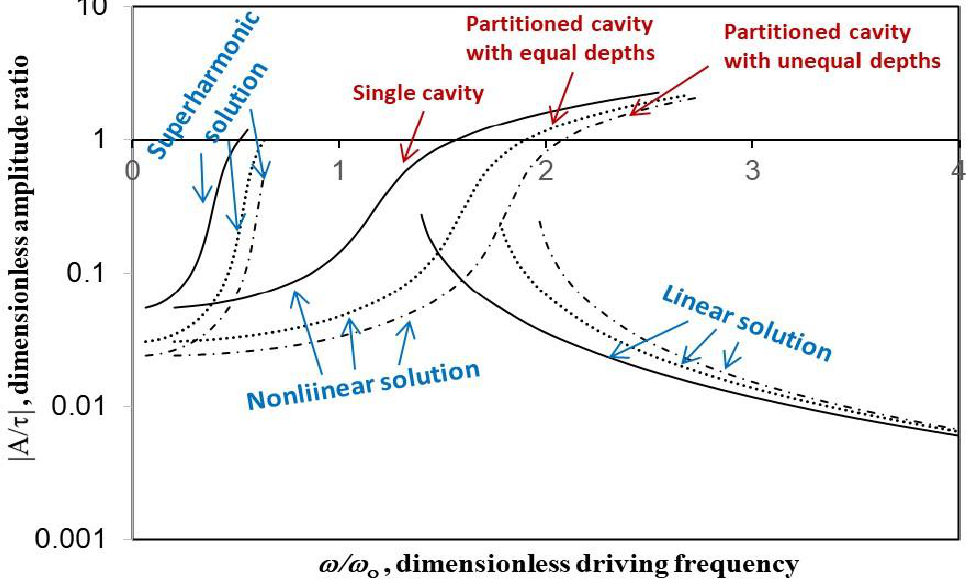
Figure 7. Amplitude ratio versus excitation frequency for various cavity cases ( c/a = 0.5, k = 5, ξ = 0.02).